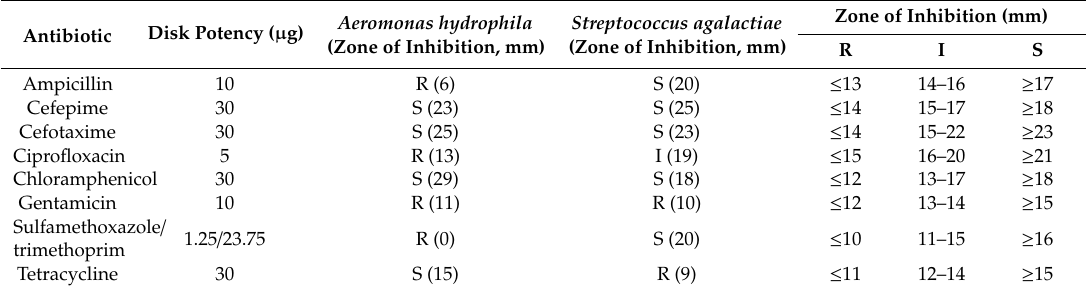
Table 1. Antibiotic susceptibility of Aeromonas hydrophila and Streptococcus agalactiae isolated in red hybrid tilapia using the disk di ff usion